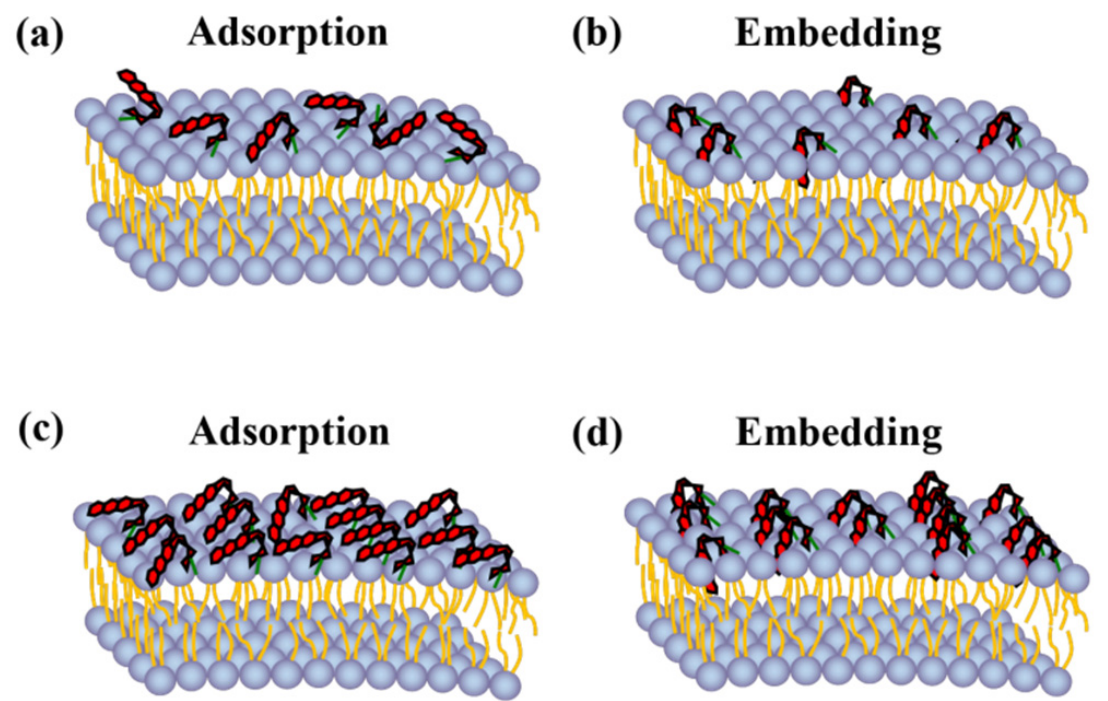
Figure 6. Illustrations of the adsorption and embedding of DOX molecules on the surface of DOPG vesicles at relatively low ( a , b ) and high ( c , d ) DOX concentrations. Reproduced with permission [57]. Copyright 2019 American Chemical Society.